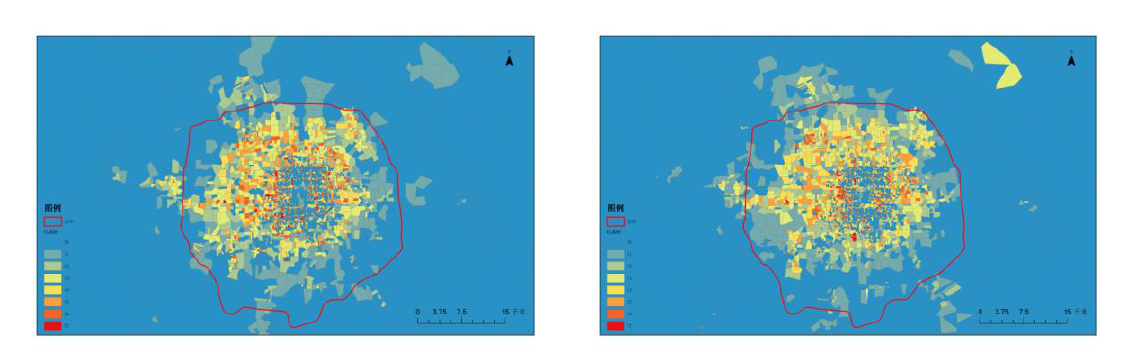
Figure 2(A). The clustering results of O-point Figure 2(B). The clustering results of D-point Figure 2. The clustering results of 07:00~10:00 on weekday